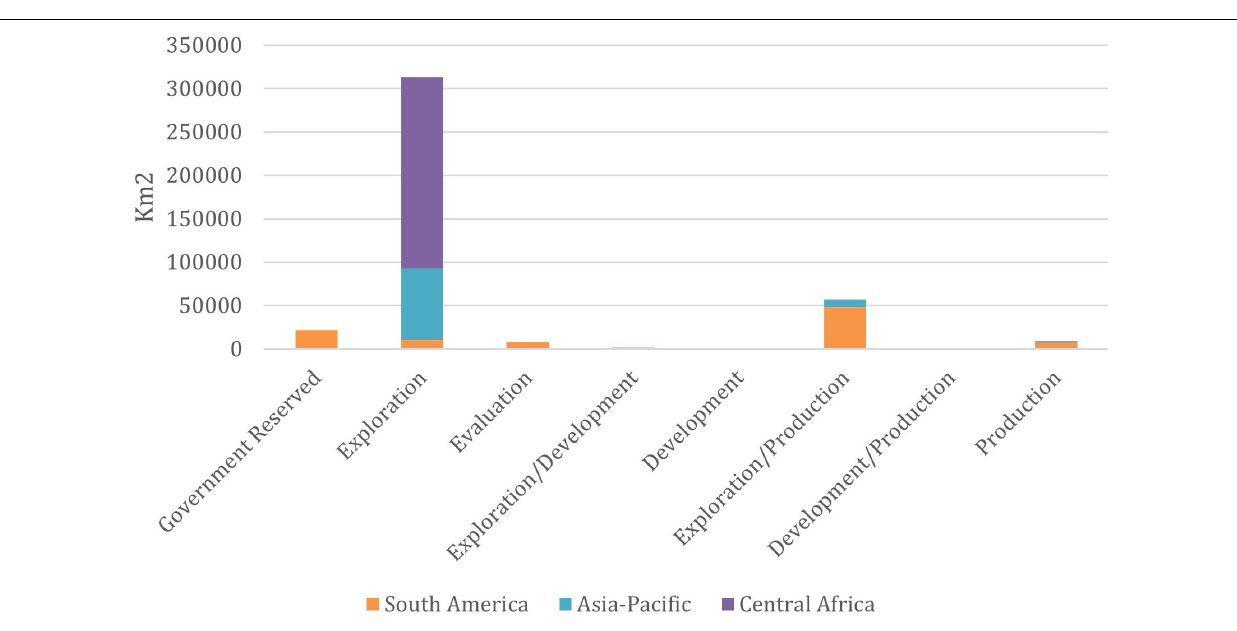
FIGURE 5 | Stage of operations for oil and gas contracts where contracts overlap